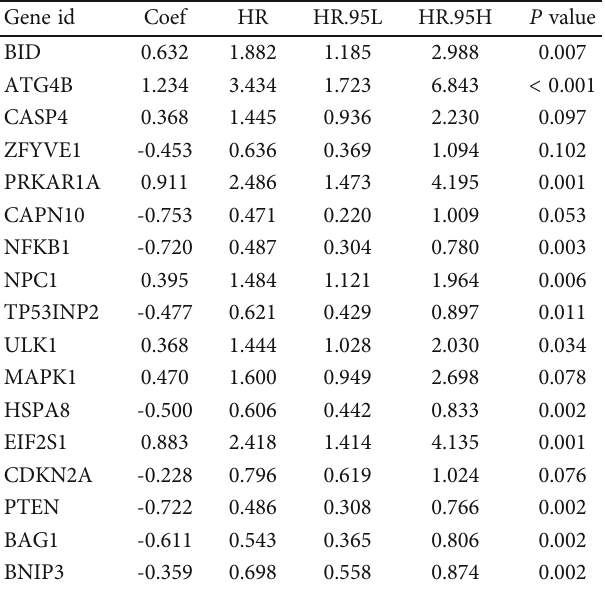
Table 3: The multivariate Cox regression analysis for ARGs of overall